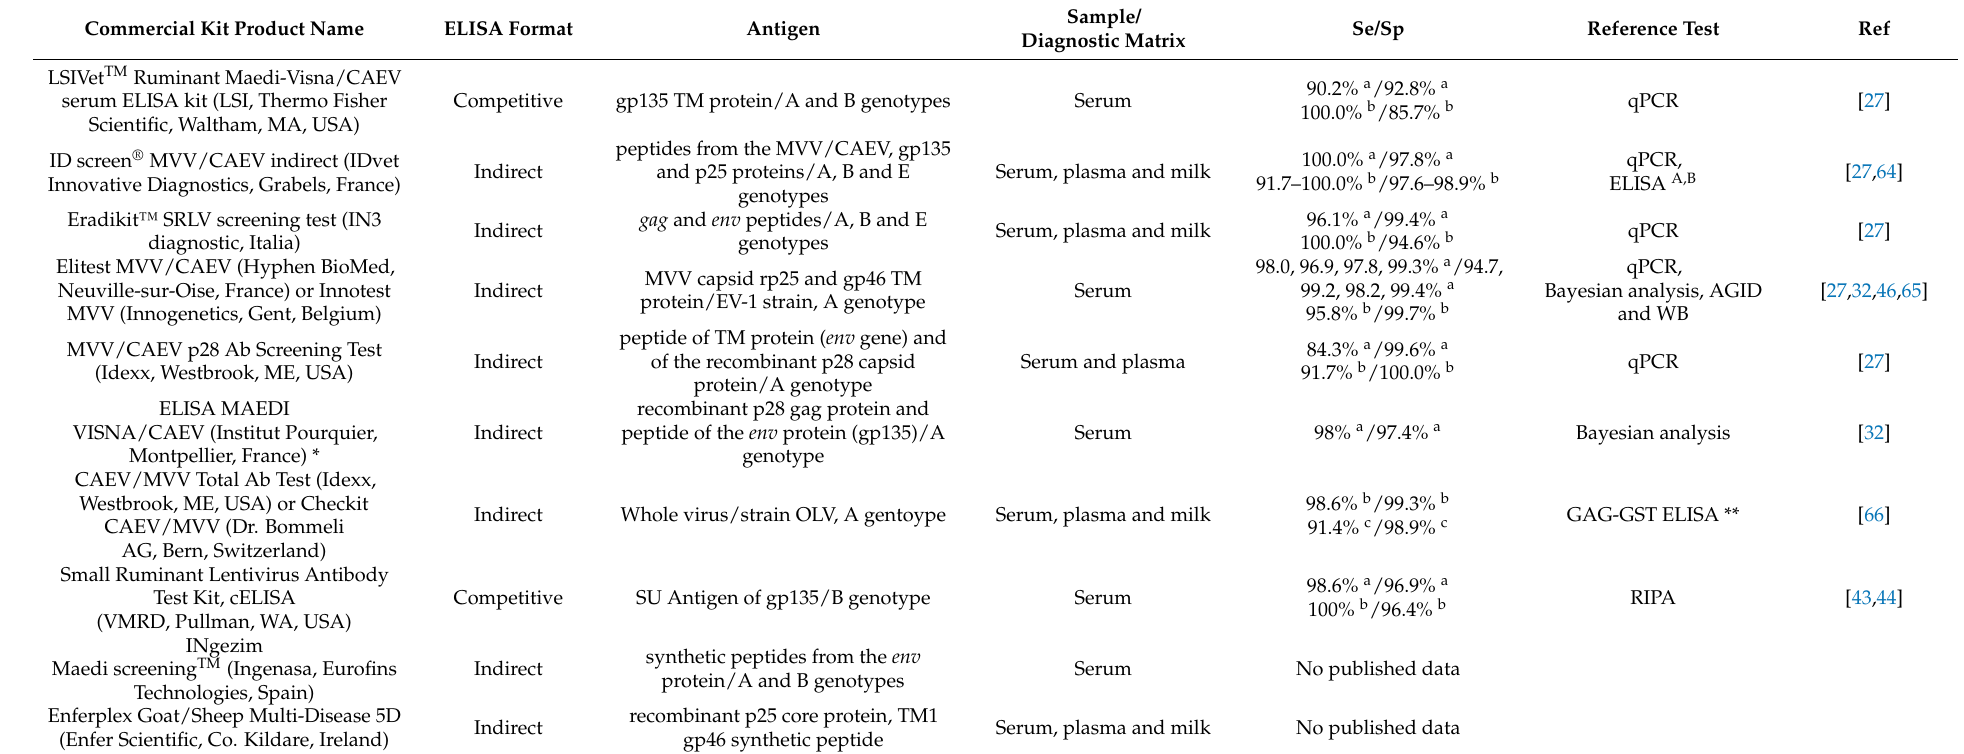
Table 1. Commercially available ELISA kits used for the diagnosis of SRLV